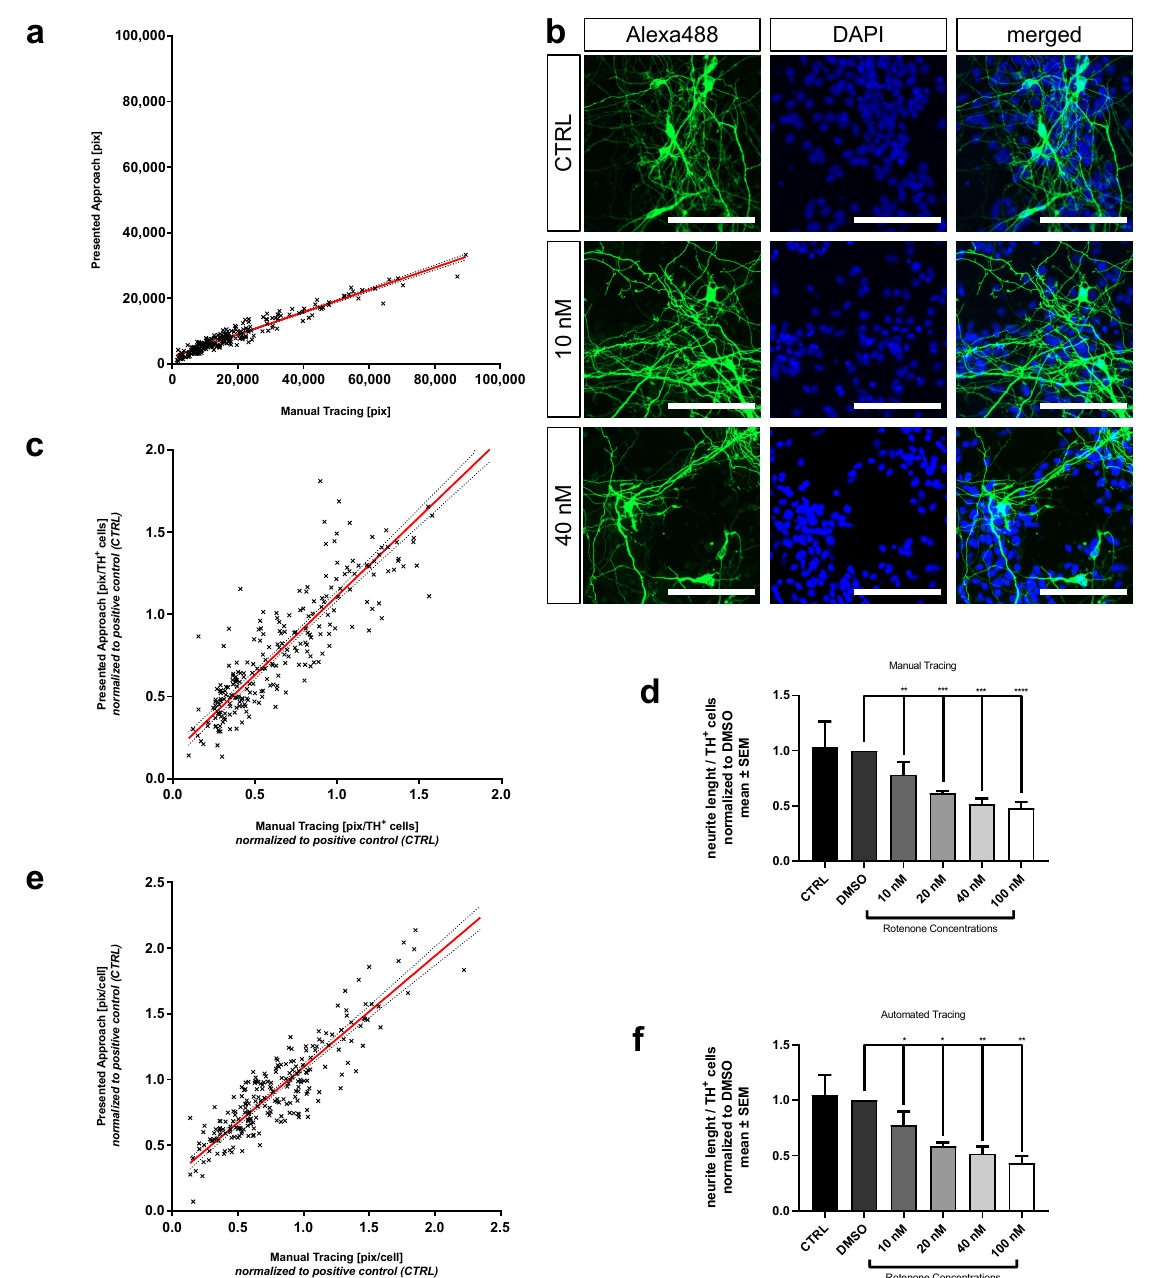
Figure 5. Further validation with MDN. ( a ) Linear regression performed on results of summed neurite length per im- age quantified with the presented approach and manual analysis using NeuronJ. ( y = 0.3403 · x + 2109; R 2 = 0.9297) ( b ) Representative micrographs showing a selection of experimental conditions (positive control (CTRL) and 10 nM and 40 nM Rotenone). Stained against TH (green). Cell nuclei were stained with DAPI (blue). Scale bar = 100 µm. ( c ) Linear regression performed on results of neurite length normalized to the number of TH + -cells and afterwards to positive control. ( y = 0.9605 · x + 0.1517; R 2 = 0.8296) ( d ) Neurotoxic effects of Rotenone on the neurite network of MDN quantified with manual analysis. Mean neurite length per cell normalized to TH + -cells. ( e ) Linear regression performed on results of neurite length normalized to cell count and afterwards to positive control. ( y = 0.8460 · x + 0.2482; R 2 = 0.7959) ( f ) showing the neurotoxic effects of Rotenone quantified using the presented neurite outgrowth quantification assay. Mean neurite length per cell normalized to TH + -cells. Data are shown as mean ± SM. * Significantly different ( p < 0.05) between mean of solvent control (DMSO) and mean of according Rotenone treatment condition. Respectively ** with p < 0.01, *** with p < 0.001 and **** with p <